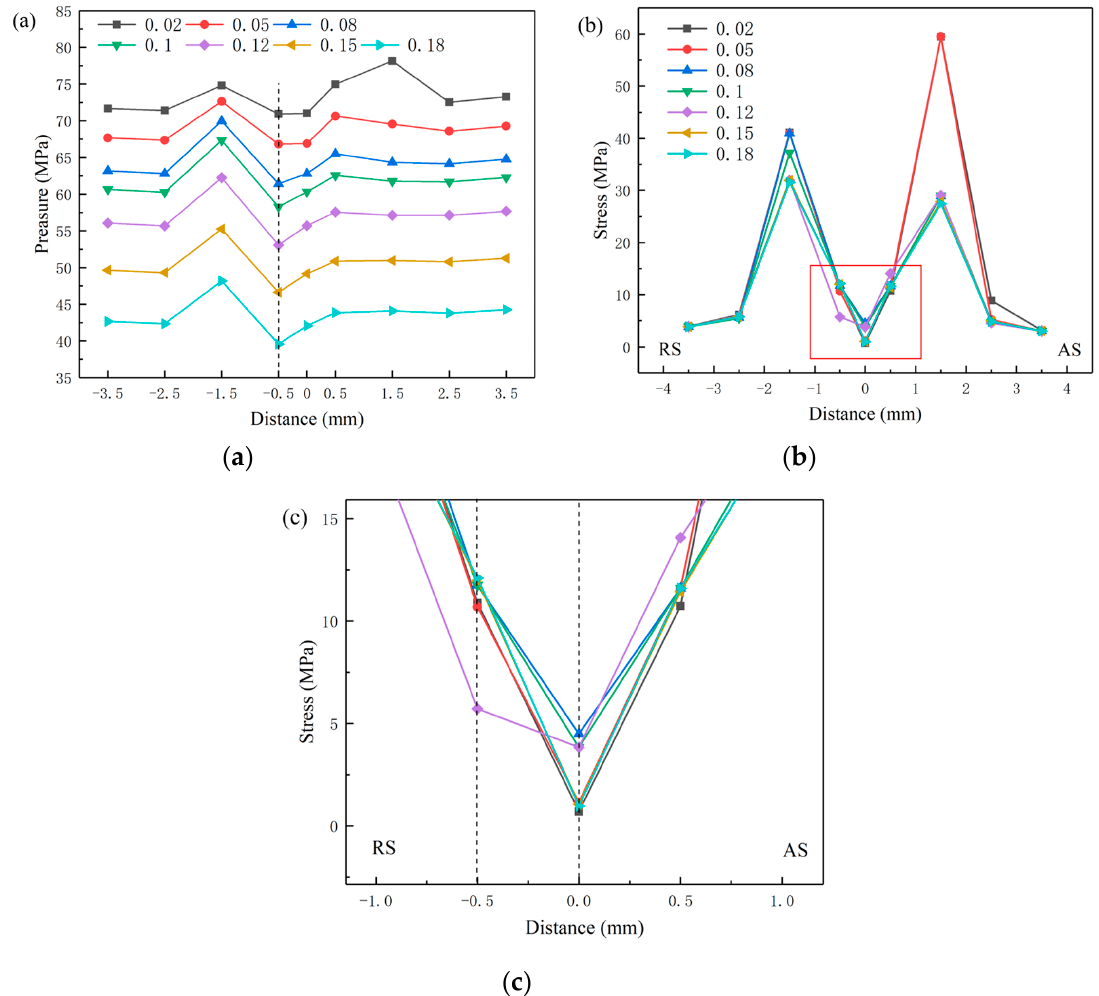
Figure 8. Distribution of the driving force at a different distances from the end face of the pin (1000 rpm, 120 mm/min). ( a ) Pressure distribution; ( b ) shear stress distribution; ( c ) partial enlargement of (b).